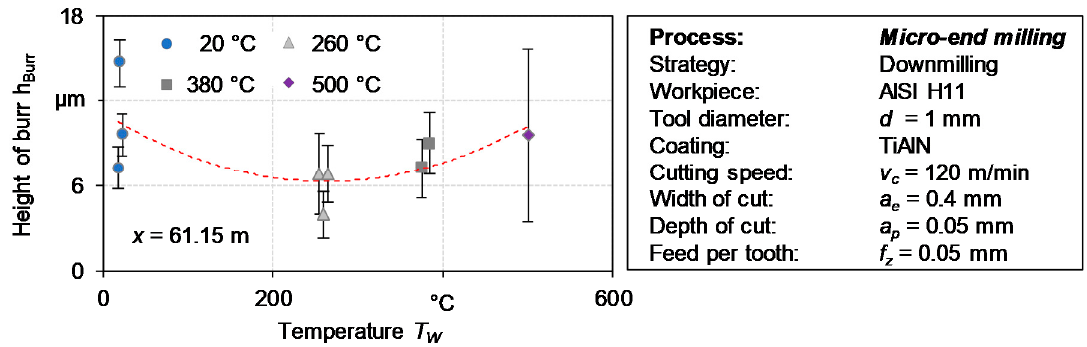
Figure 8. Top burr height h Burr by thermally assisted micromilling a HWS AISI H11.